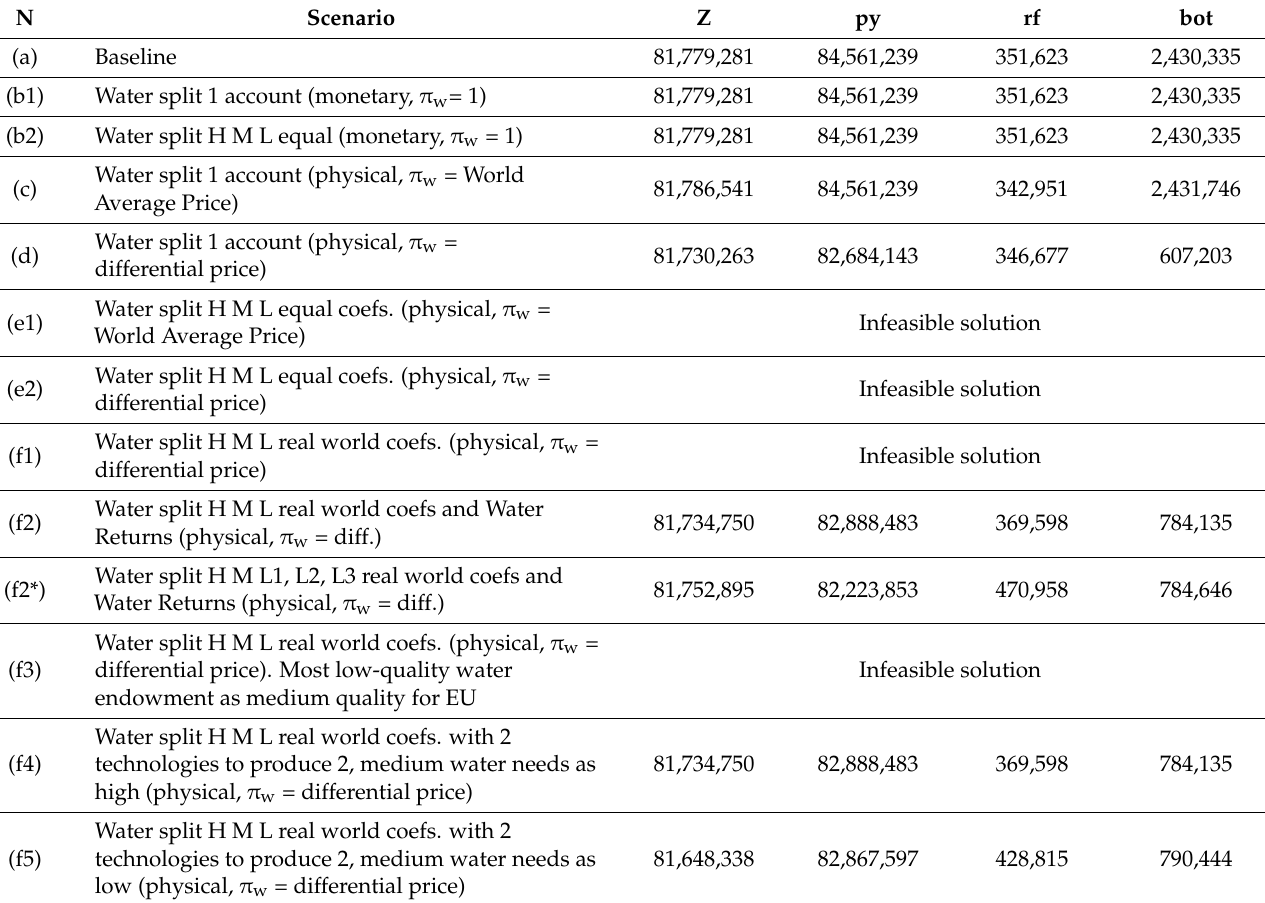
Table 16 summarizes the results for each of the scenarios. Table 16. Summary of results for each of the scenarios (million